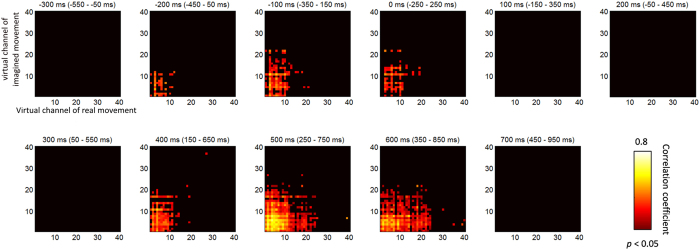
Temporal correlation of decoding accuracy between real and imagined movements.Each plot depicts the correlation coefficients averaged over subjects at each time window. Temporal correlation began to increase significantly from −200 ms (from −450 to 50 ms) around the medial part of cM1, particularly around the hand and arm areas. These significant correlations disappeared around response onset and reappeared from 400 ms (150–650 ms). Correlation coefficients at p < 0.05 were considered statistically significant and were plotted (Spearman’s rank correlation test, p < 0.05, false discovery rate-corrected).